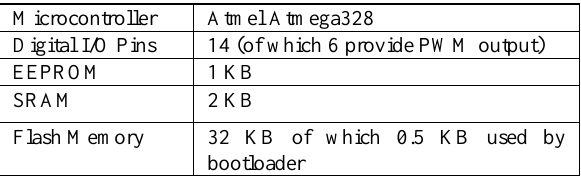
Table 1. Arduino UNO Rev3 main